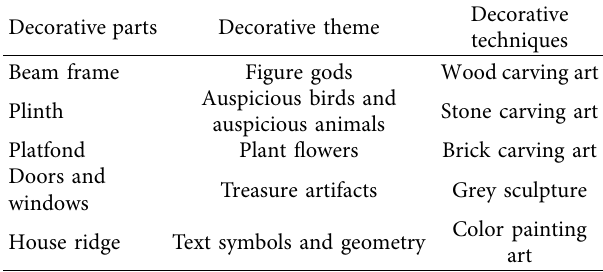
Table 1: Characteristics of Hakka traditional architectural deco- ration art.